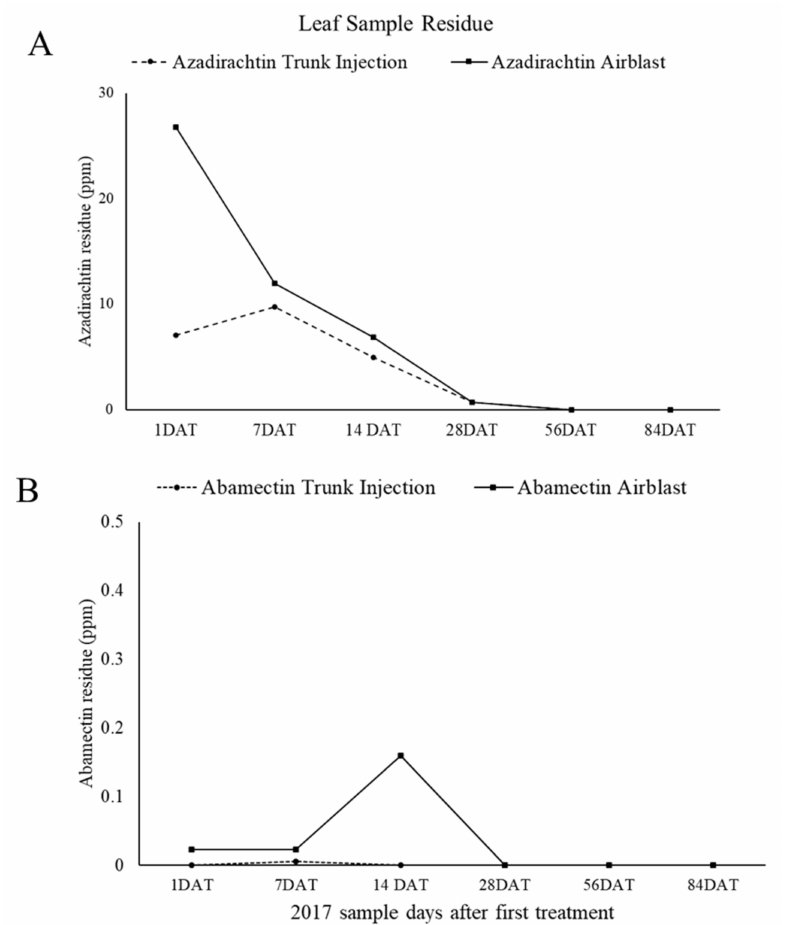
Figure 5. Mean residue from leaf samples taken in 2017 azadirachtin trunk injection and airblast treatments ( A ) and of abamectin trunk injection and airblast treatments ( B ). Samples were taken 1, 7, 14, 28, 56, and 84 days after treatment (DAT). Residue is presented as ppm ( µ g / mL) above the level of detection (LOD) (abamectin LOD = 0.001 ppm) (azadirachtin LOD = 0.005 ppm). No residue was detected after 28 DAT for both abamectin and